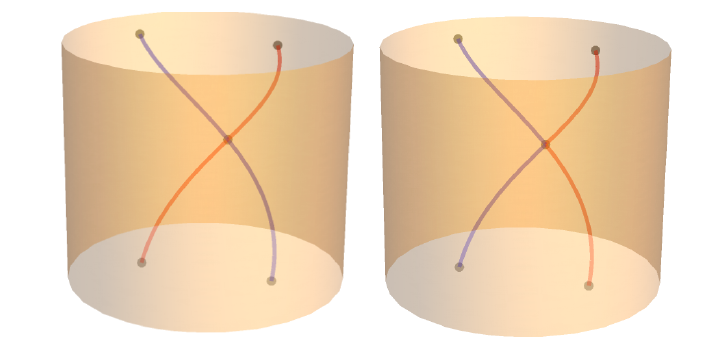
Figure 9. Two different orbispace paths corresponding to the same singular braid.